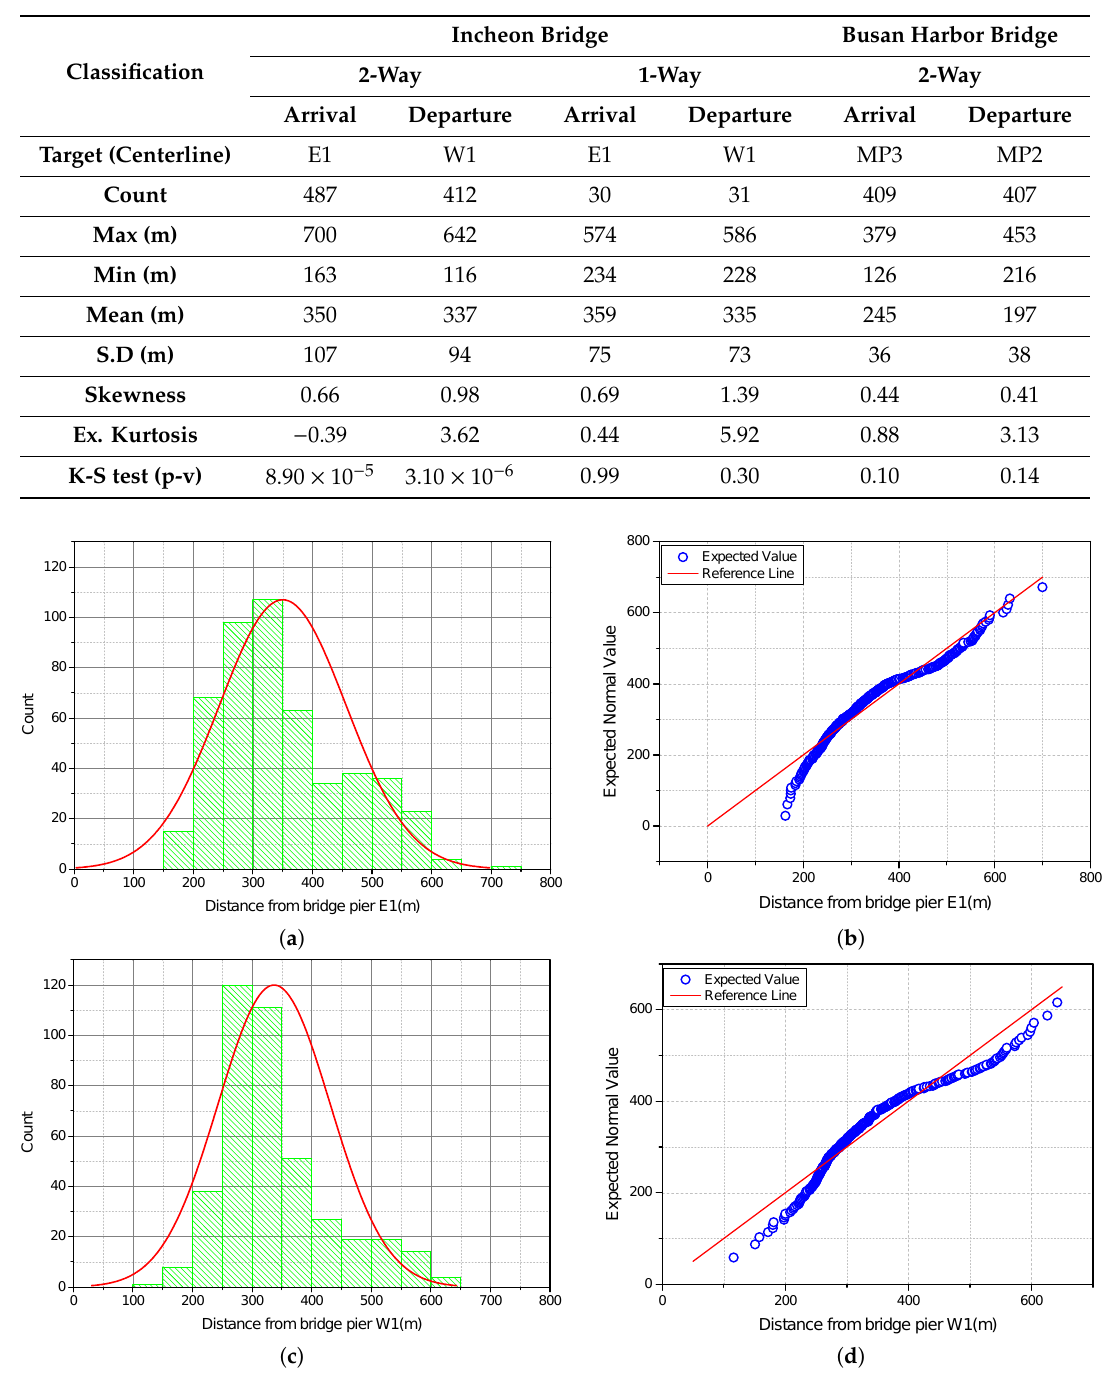
Figure 8. Histogram and Normal Q–Q plots for the Incheon bridge data for ( a , b ) 2-way arrival and ( c , d ) 2-way